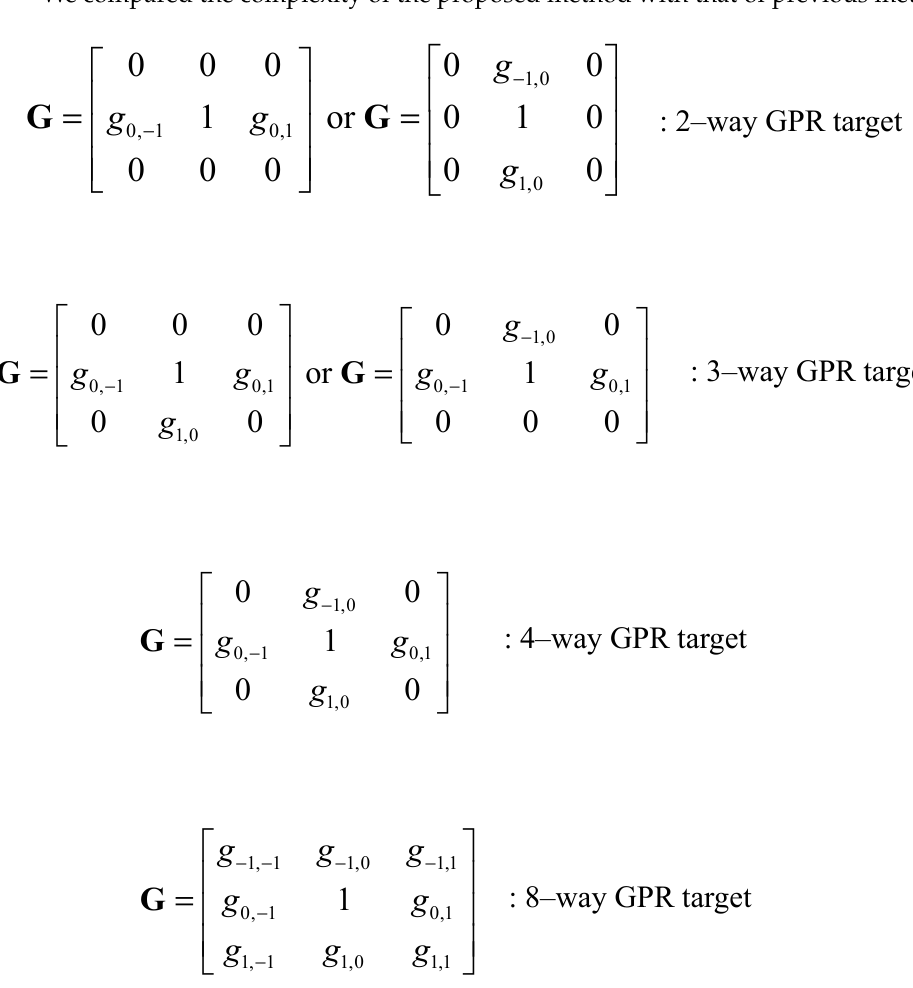
Figure 1. Definitions for the N -way GPR targets [21].